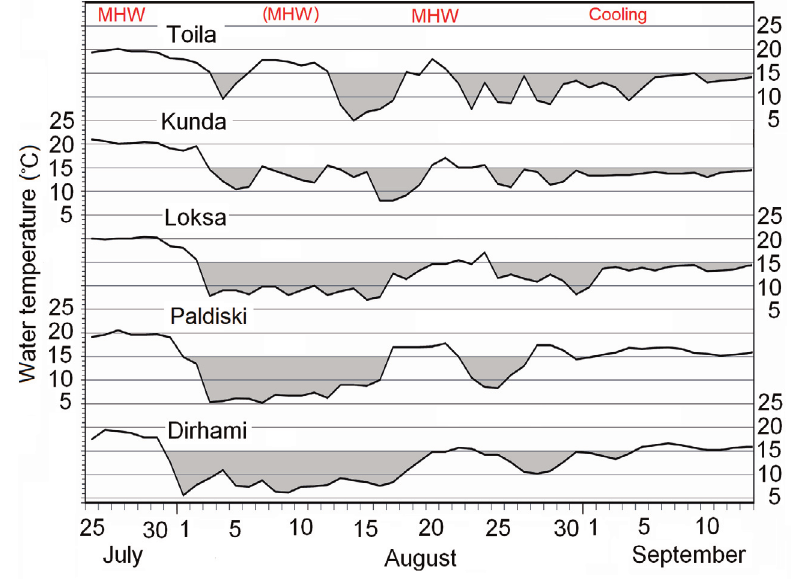
Fig. 8. Example of variations in water temperature at marine stations (by the EWS) along the northern coast of Estonia (see Fig. 1) between 25 July and 14 September 2006 (modified from Suursaar & Aps 2007). The grey areas indicate CUs (temperatures <15 °C) occurring between the MHWs.